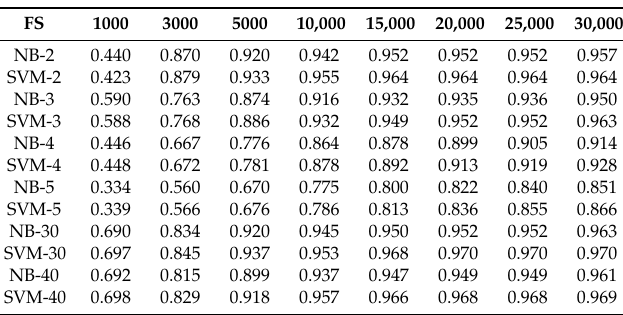
Table 11. Results of LI in one-stage LI. FS, feature size.